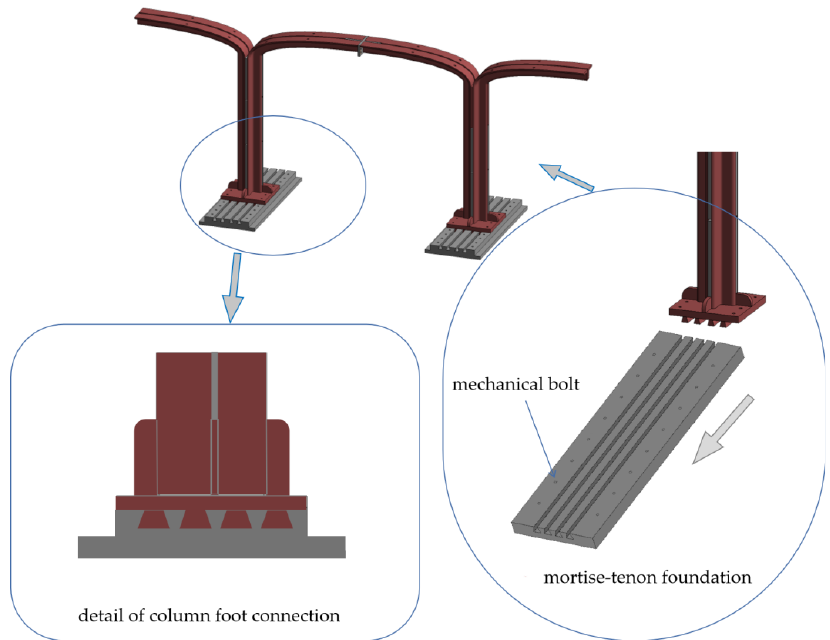
Figure 13. Schematic diagram of the mortise-tenon foundation and its connection.